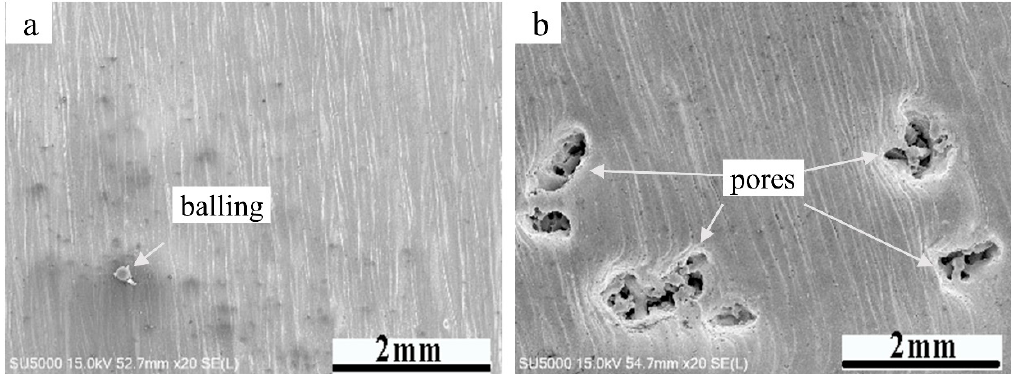
Figure 4. Defects of Ti-6Al-4V produced by electron beam melting: ( a ) spheroidization; ( b ) pores.